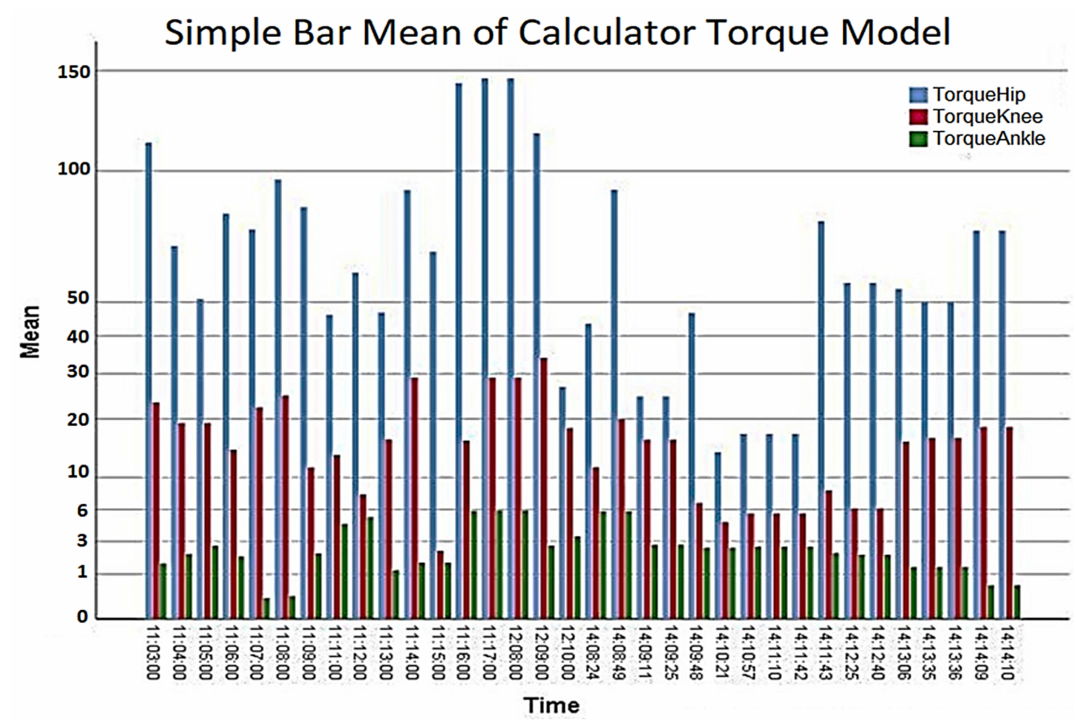
Figure 13. Simple Bar Mean of Torque Model